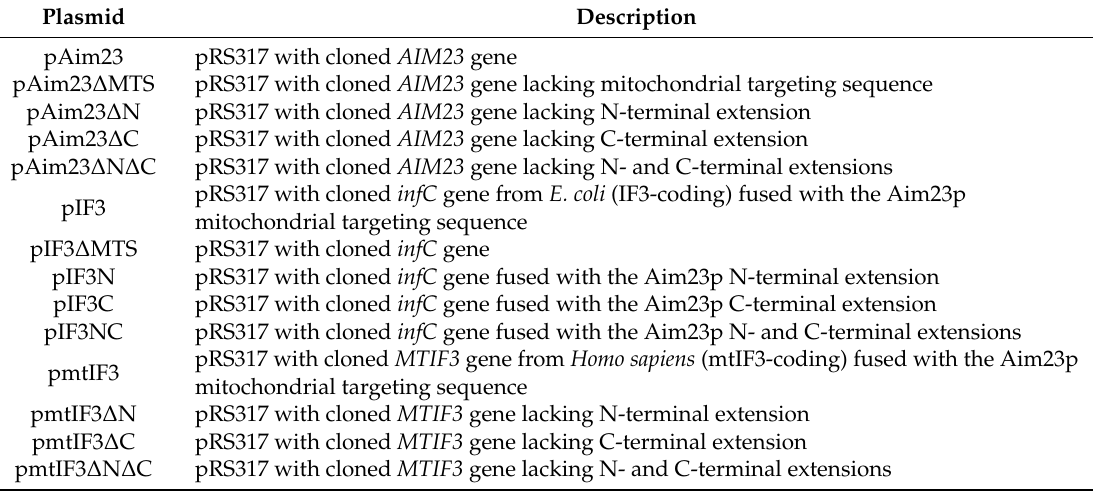
Table 1. Plasmids used.